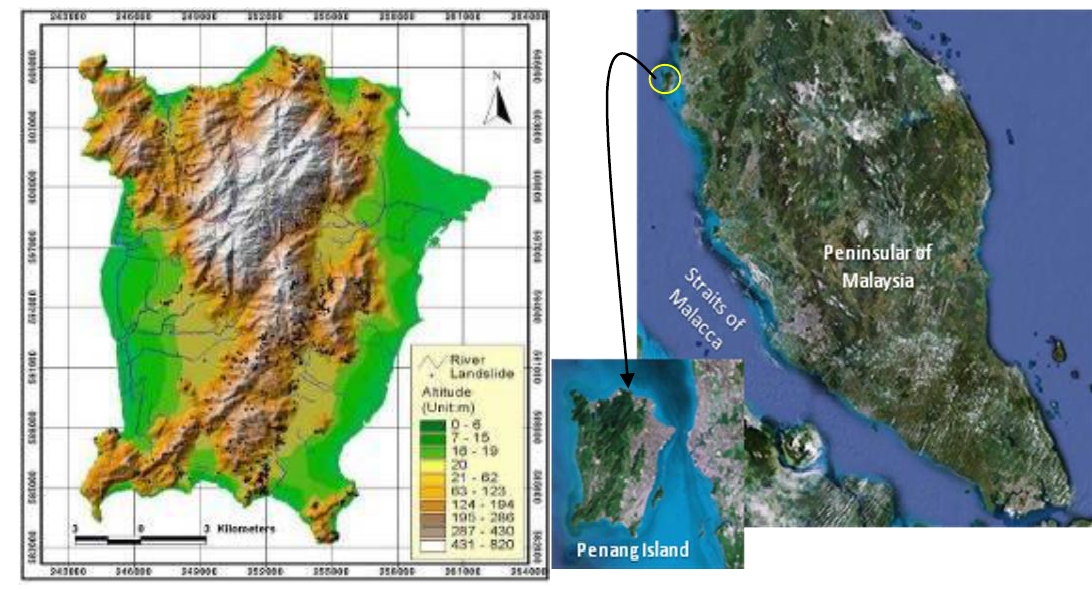
Figure 3. Location of the study area and